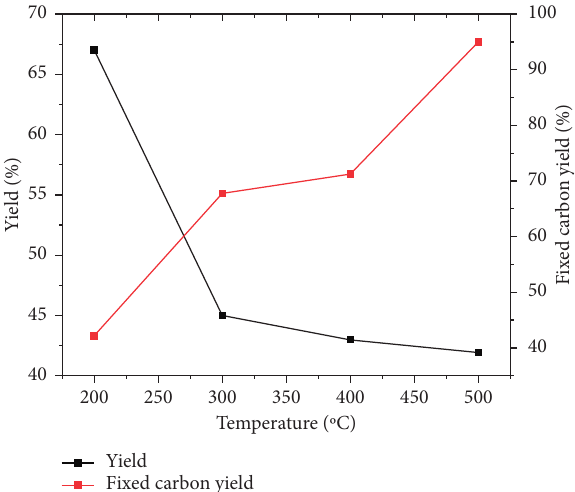
Figure 10: Effect of temperature on yield and quality of char. Table 4: Effect of heating time on yield and quality of